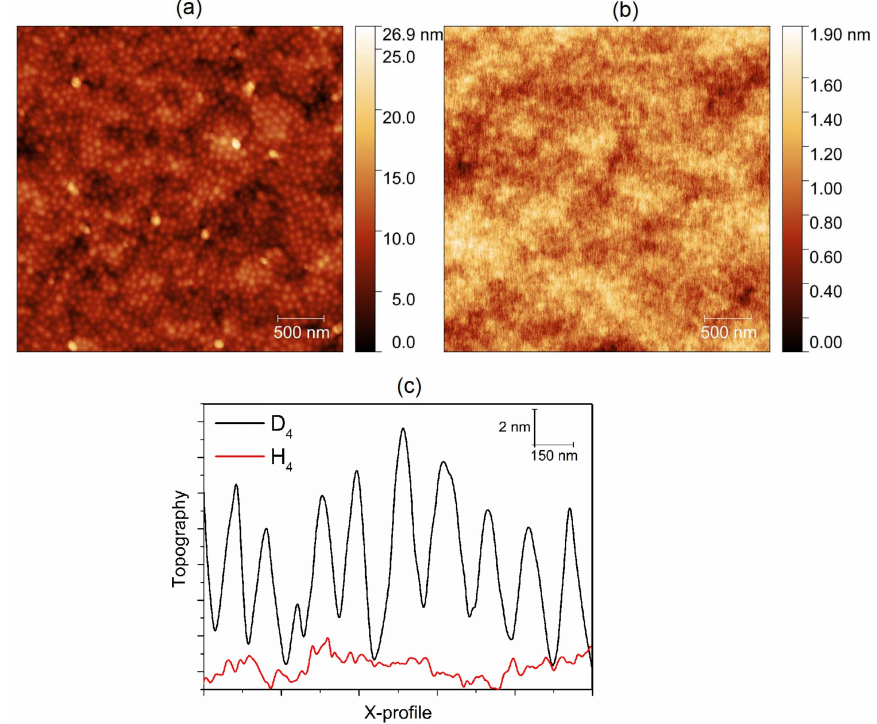
Figure 6. AFM images of latex coating films performed in the topographical mode: ( a ) sample D 4 ; ( b ) sample H 4 ; ( c ) topographical profiles for samples D 4 and H 4